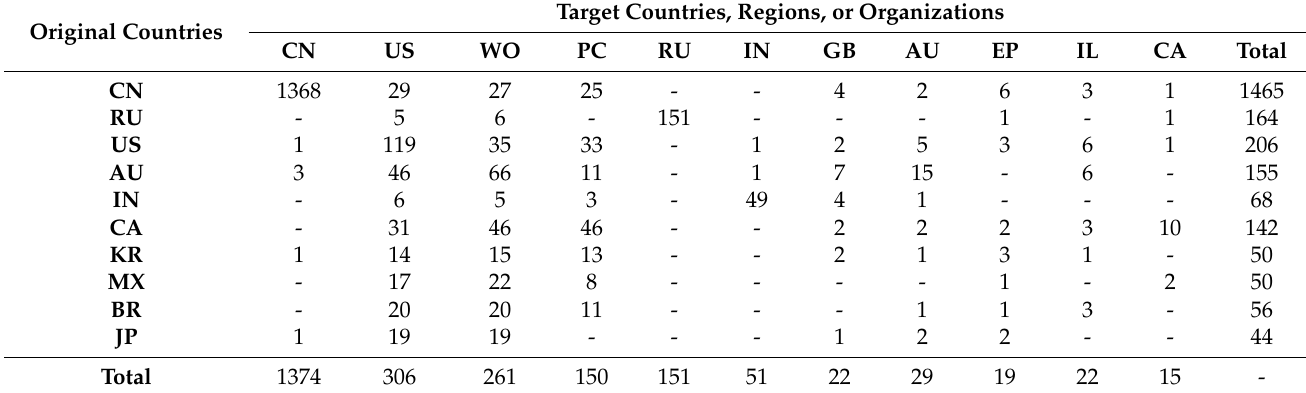
Table 5. Numbers of patents applied for by